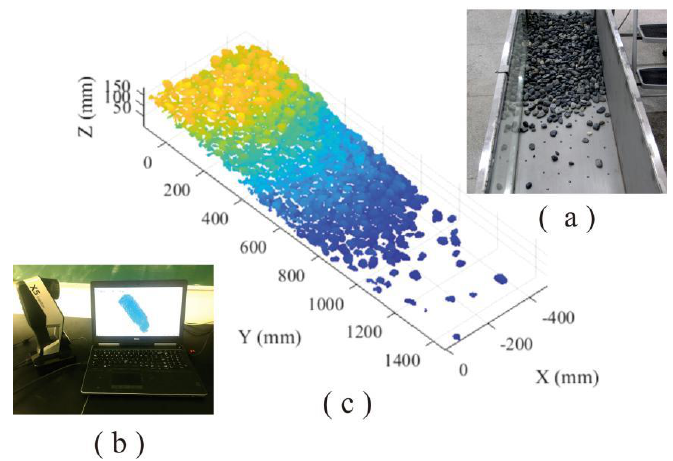
Figure 2. The collection of point cloud in laboratory physical model: ( a ) particle loose accumulation, ( b ) portable laser scanner, and ( c ) point cloud of accumulation.